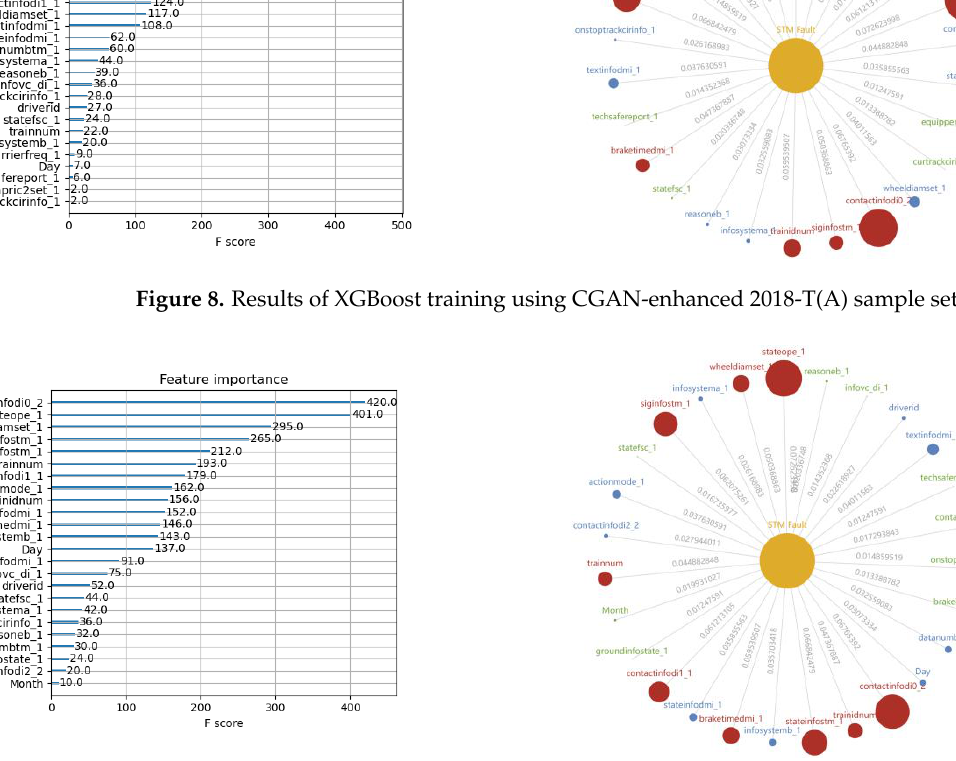
Figure 9. Results of XGBoost training using CGAN-enhanced 2018-T(B) sample set.